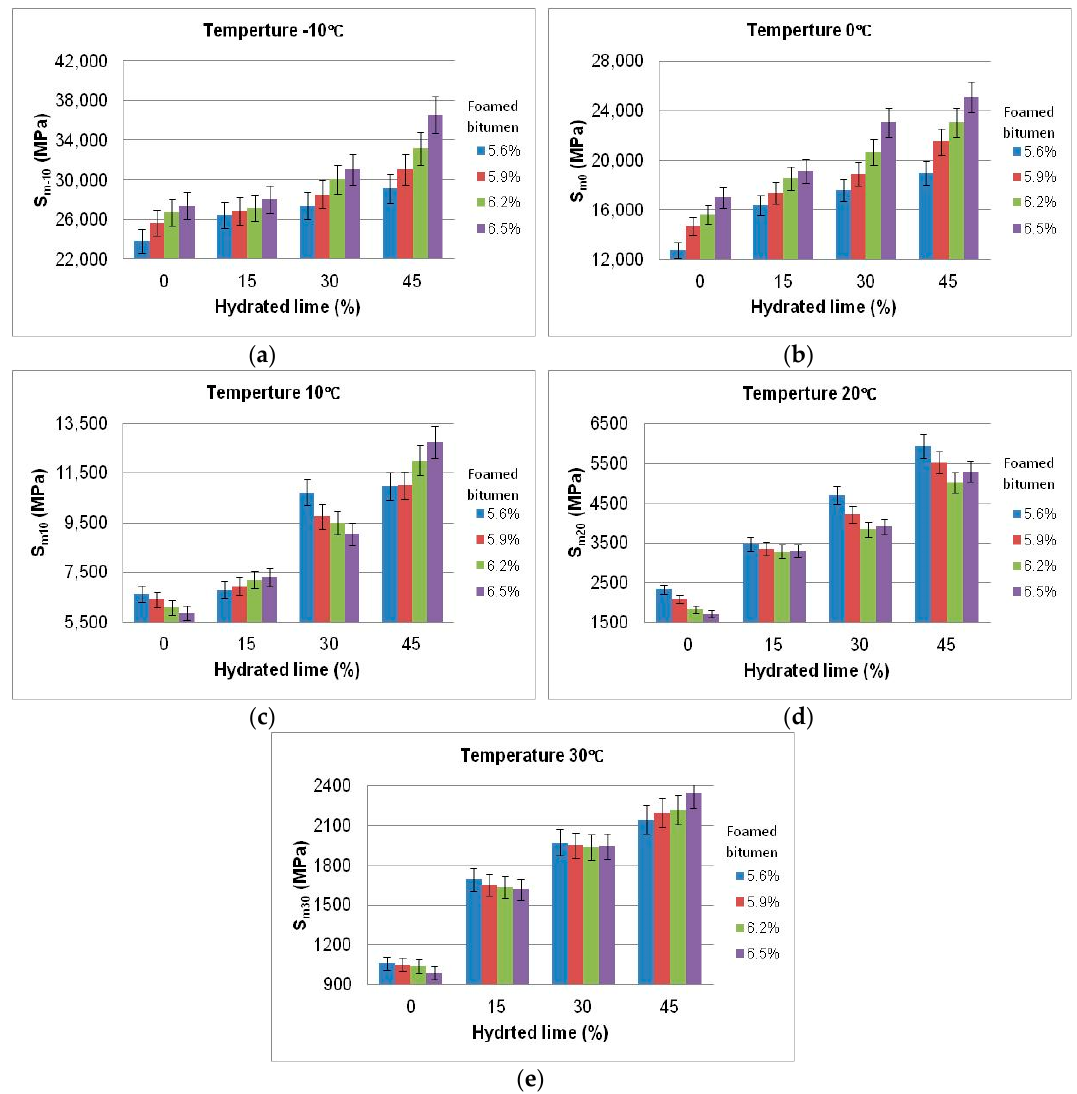
Figure 7. Stiffness modulus (S m ) (IT-CY) of asphalt concrete AC 8 S, as a function of the contents of foamed bitumen and hydrated lime at various test temperatures, S m-10 ( a ), S m0 ( b ), S m+10 ( c ), S m20 ( d ), S m30 ( e )